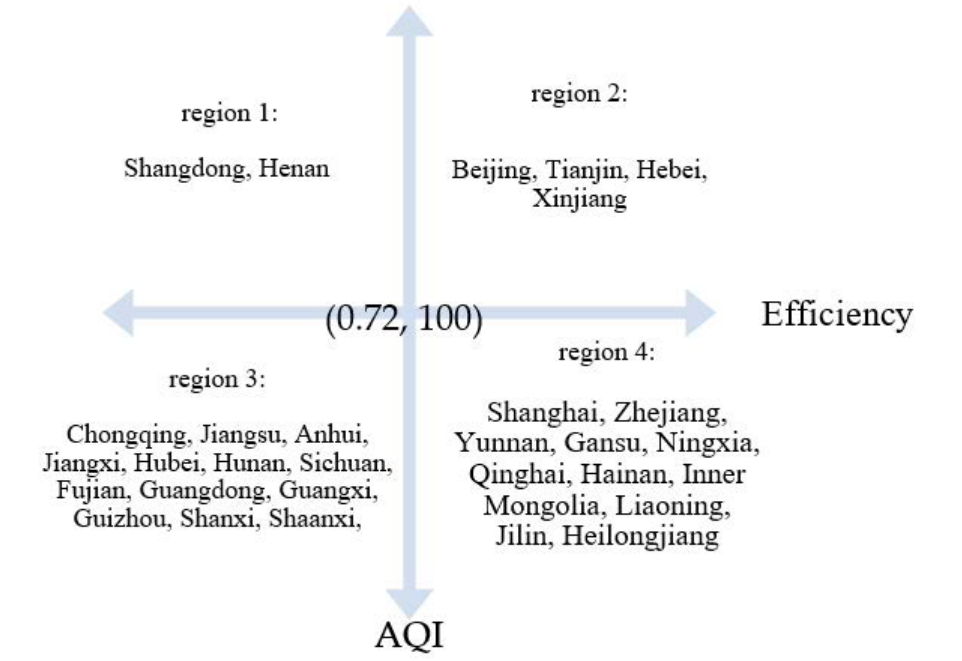
Figure 2. The relationship of energy using efficiency and AQI in China’s provincial